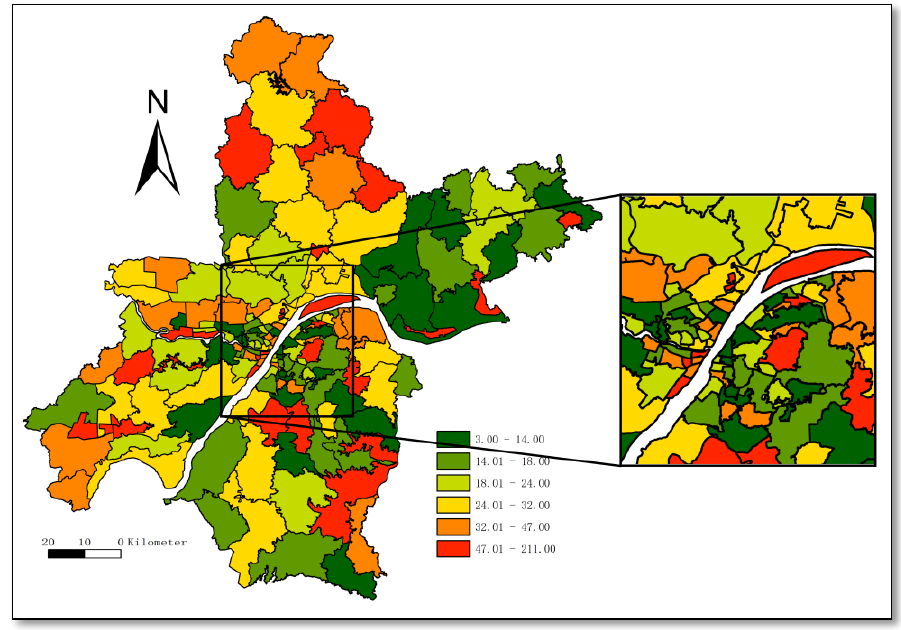
Figure 5. Accumulated mobility of criminal incidents.